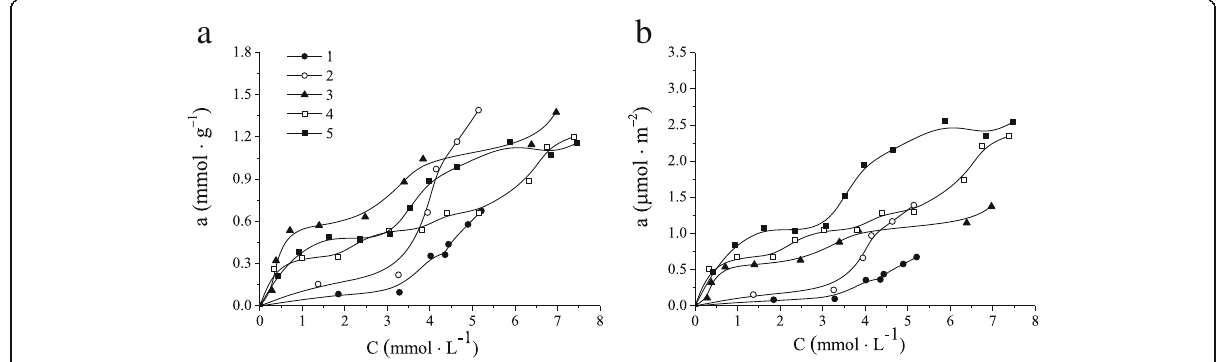
Fig. 6 Benzene adsorption isotherms on MCM-41 ( 1 ), NH 2 -MCM-41 ( 2 ), β -CD-APTES-MCM-41 ( 3 ), β -CD-APTES 3 -MCM-41 ( 4 ), and β -CD-APTES 5 -